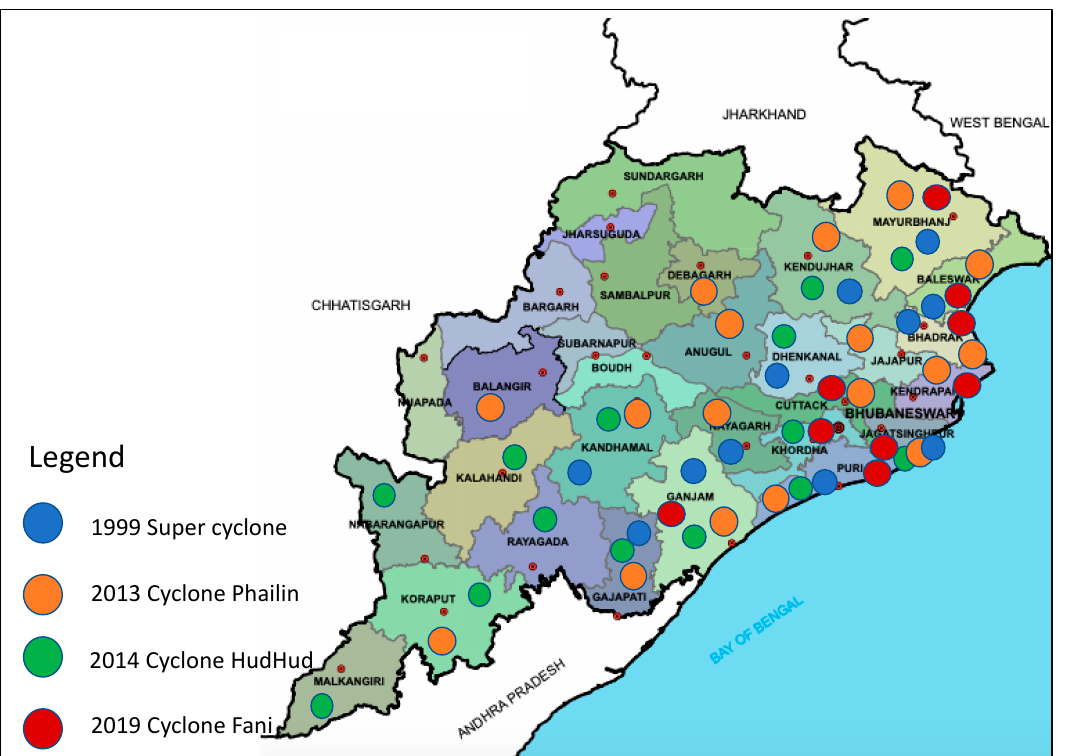
Figure 4 . Cyclone risk in Odisha (above); Cyclone affected districts of Odisha (below) (Source: